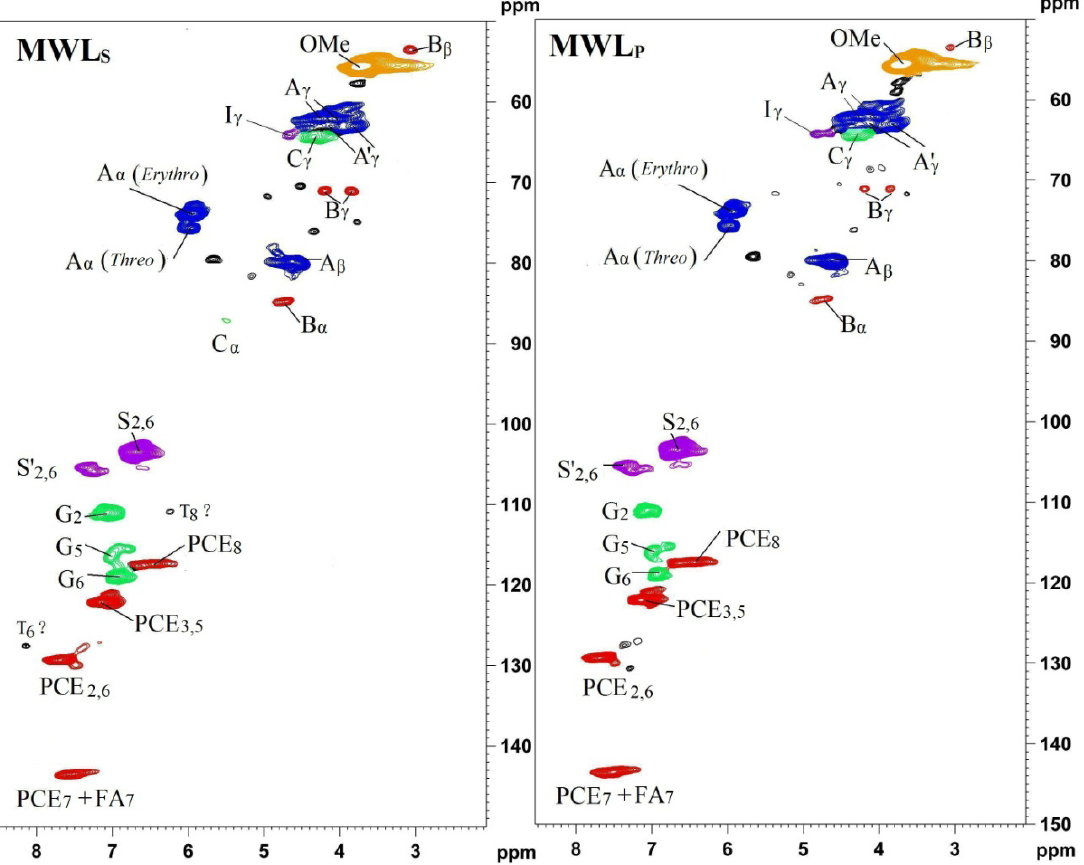
Figure 5. 2D-HSQC-NMR spectra of acetylated bamboo MWL specimens (MWL represents MWL extracted from bamboo stem. MWL bamboo pith. (Reprinted from [28]. Copyright 2013 De Gruyter).